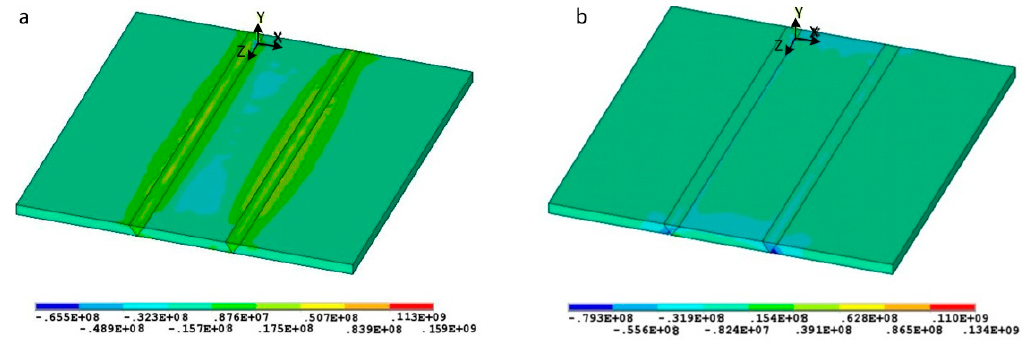
Figure 3. Residual stress distribution of 5A06 aluminum alloy butt welds ( a ) Longitudinal residual stress ( b ) Transverse residual stress.